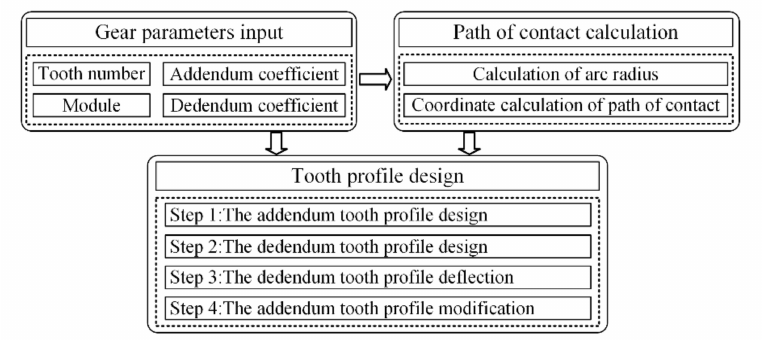
Figure 5. The flow chart of the design method for HCR internal spur gear